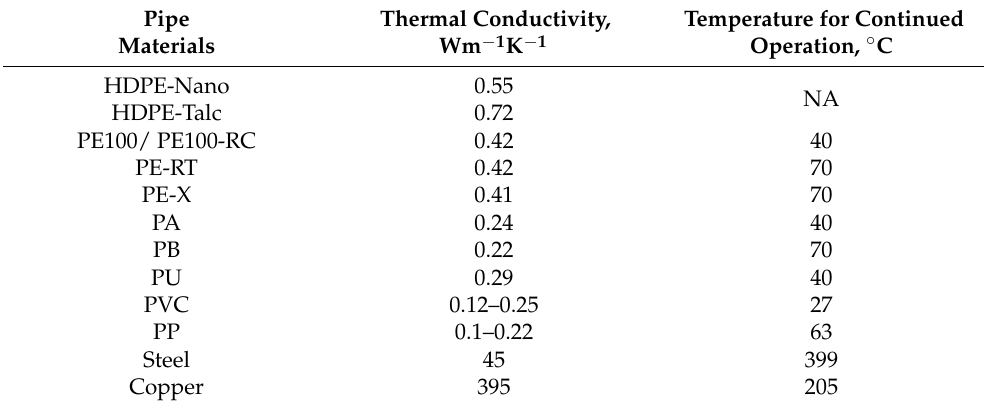
Table 1. Pipe Material Properties [33,47].